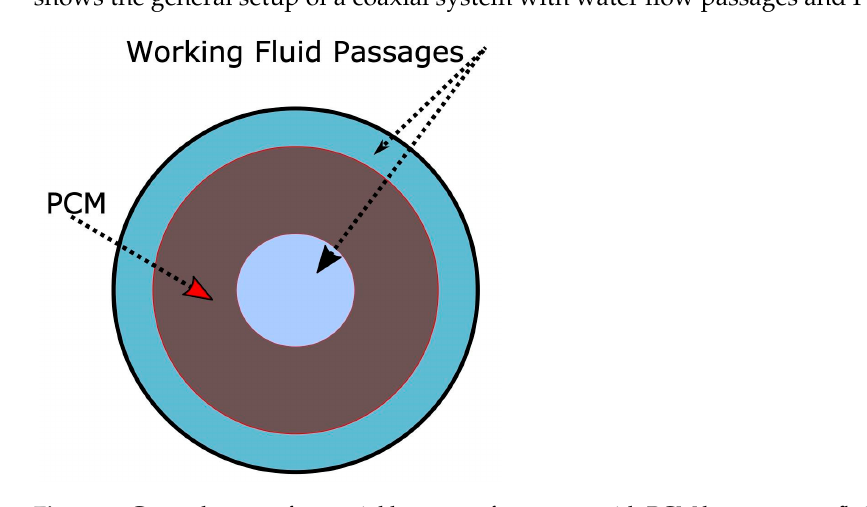
Figure 8. General setup of a coaxial heat transfer system with PCM between two fl uid fl ows